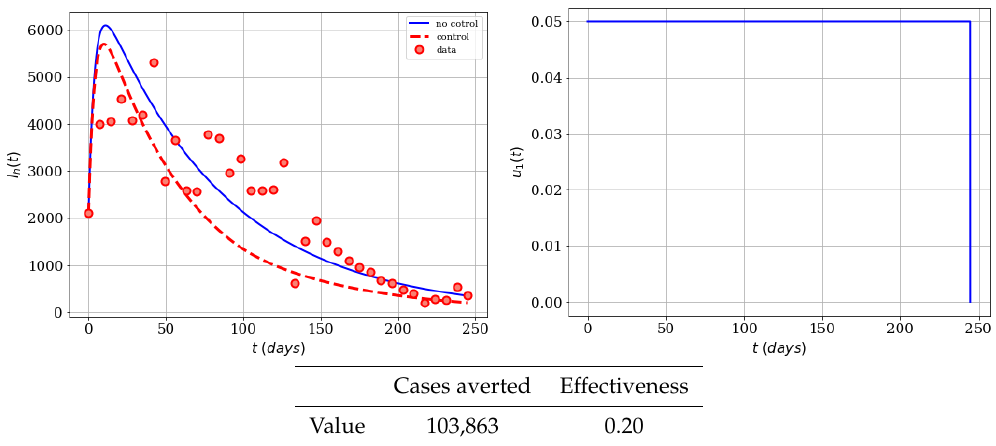
Figure 3. Numerical simulation of an educational campaign ( κ 1 = 0.1, u 1 max = 0.05) on the infected humans of the Zika mathematical model (1). Results regarding effectiveness are given in the table. The dots represent the real cases of infected people in Colombia for